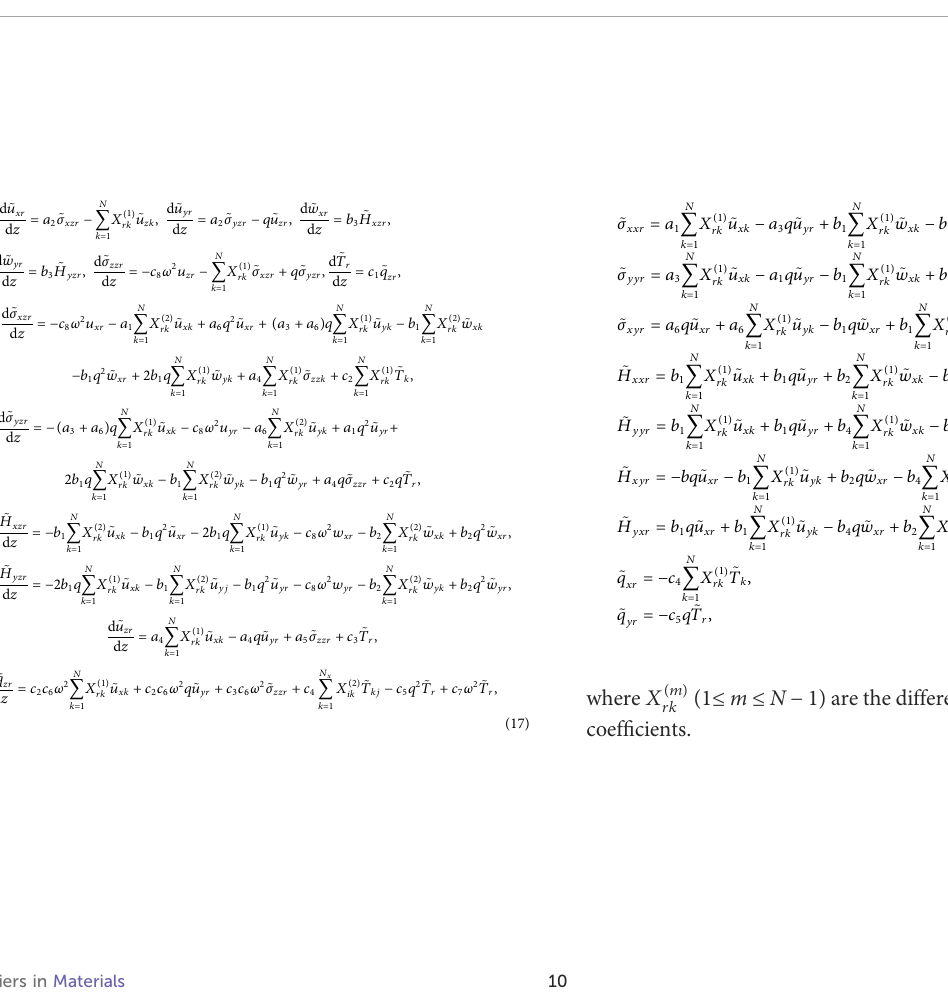
FIGURE 10 Effect of Ω on the heat fl ux q x (10 W/m 2 ): (A) Ω = 0.05, (B) Ω = 0.1, (C) Ω = 0.15, and (D) Ω =